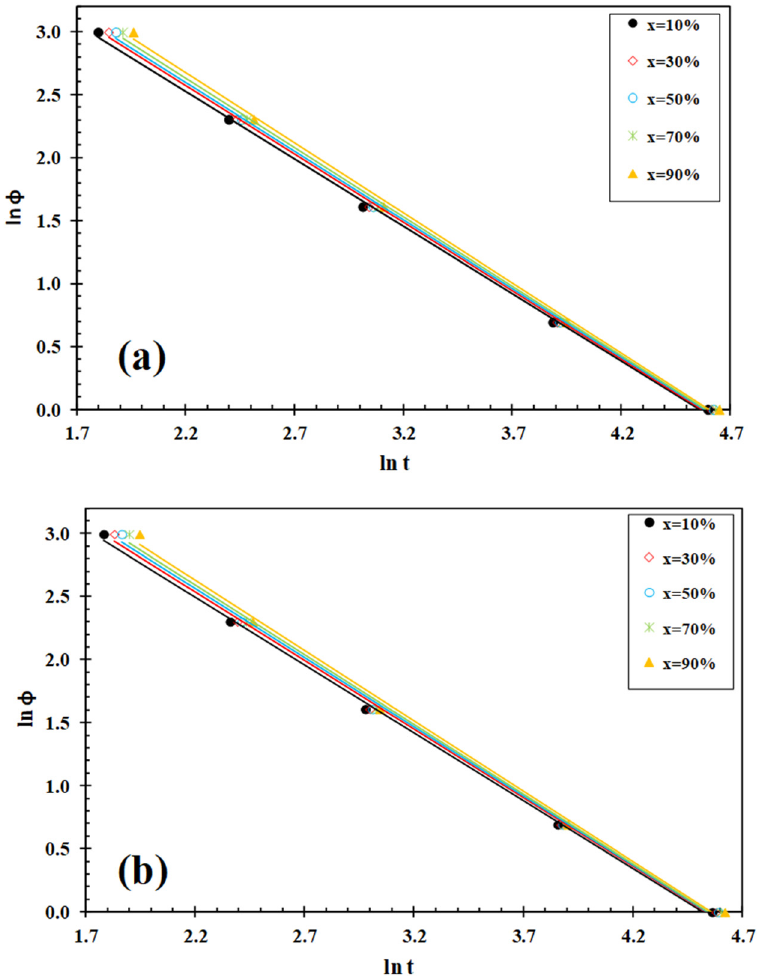
Figure 6. Liu plots for melt–crystallization of ( a ) PLLA and ( b ) PLLA/IF-WS 2 (0.5 wt%).